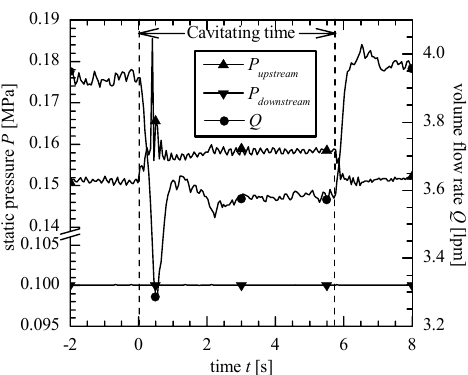
Fig. 6 Time evolution of the volumetric flow rate and the static pressure in the upstream and the downstream measured in the intermediate cavitation type ( T = 74.9 K, Q = 3.93 lpm, σ = 0.63)